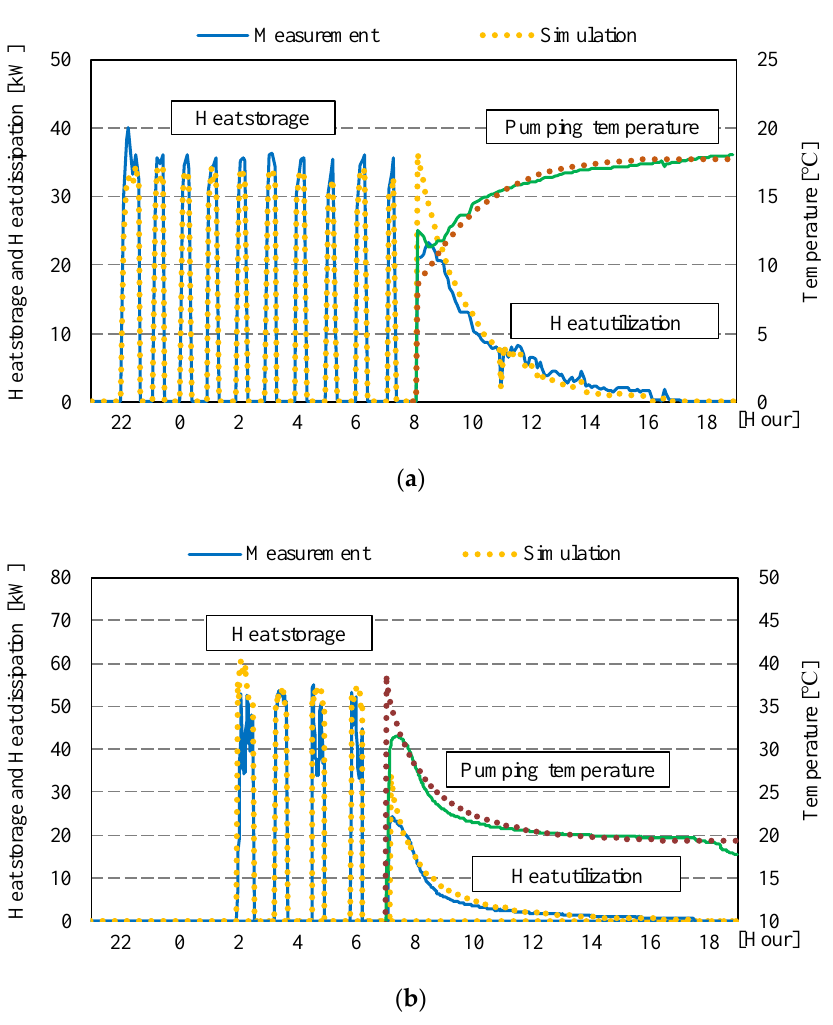
Figure 4. Accuracy verification of aquifer model. ( a ) Summer operation. ( b ) Winter operation.